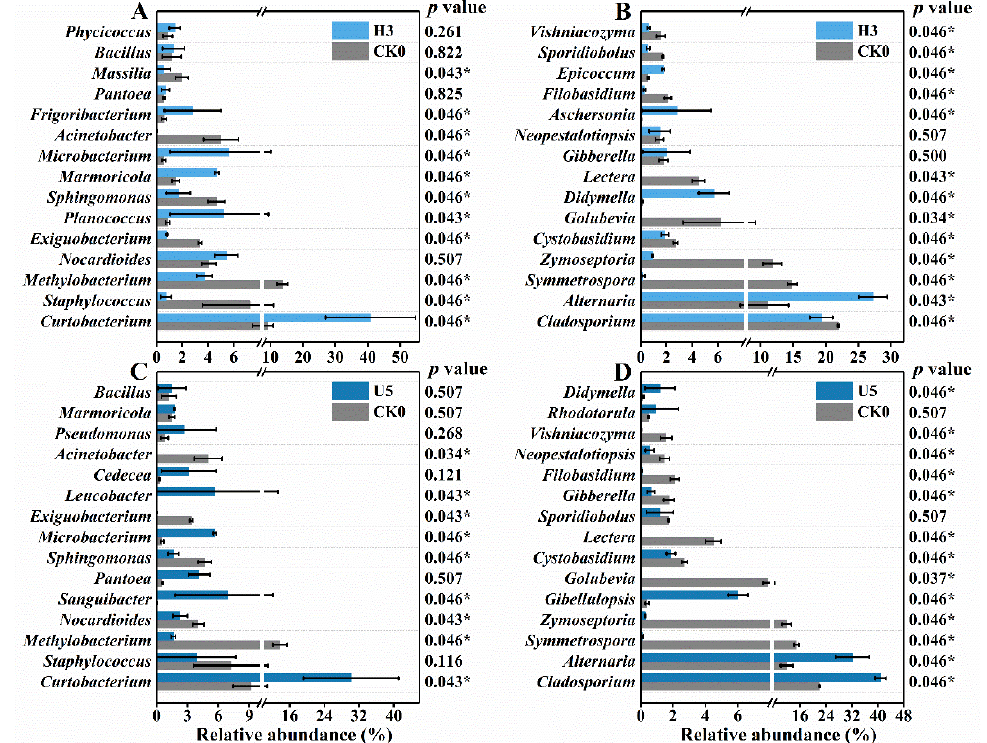
Figure 5. The microbial successions in the phyllosphere during the (ultra)high-level ozone exposure. High-level exposure: bacterial ( A ) and fungal ( B ) community compositions; ultrahigh-level exposure: bacterial ( C ) and fungal ( D ) community compositions. Error bars represent the standard deviation of replicates ( n = 3). p values were calculated by Mann – Whitney – Wilcoxon (MWW) test (* 0.01 < p ≤ 0.05).